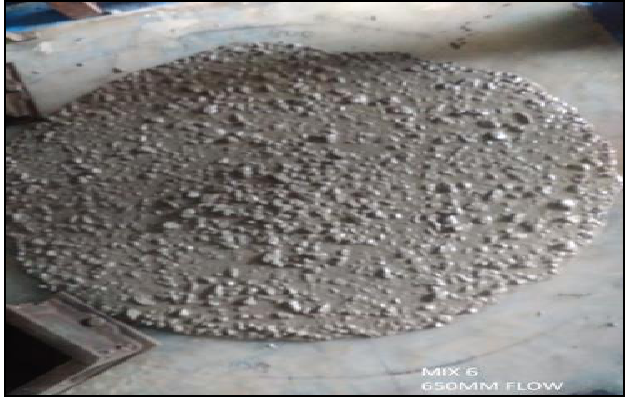
Fig. 8. Slump loss of CM 6